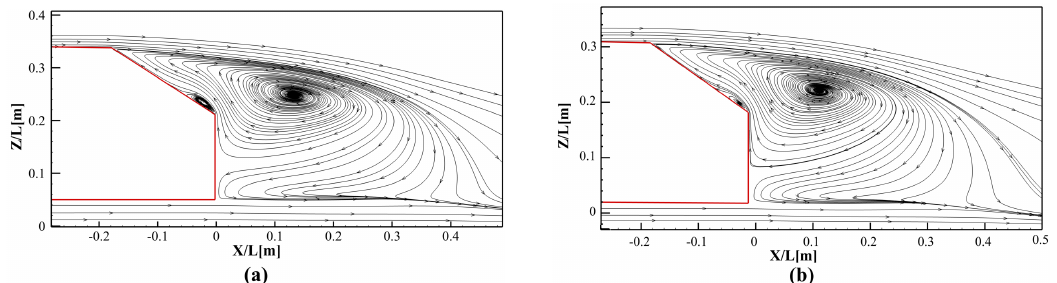
Figure 13. Streamlines on the symmetry plane for slant angle 35 ◦ and Re = 7.68 × 10 5 : ( a ) actuator off; ( b ) case 2.